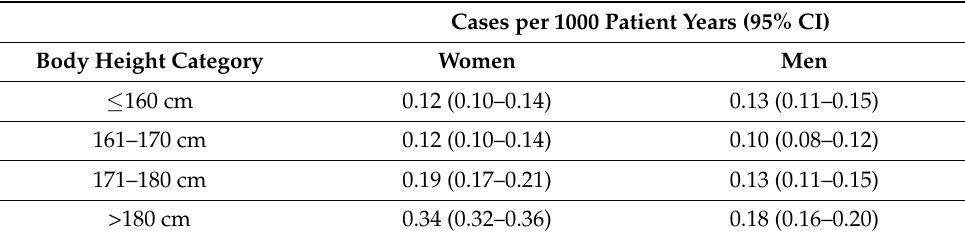
Table 3. Incidence of type 1 diabetes among patients ≤ 40 years for different body height categories.